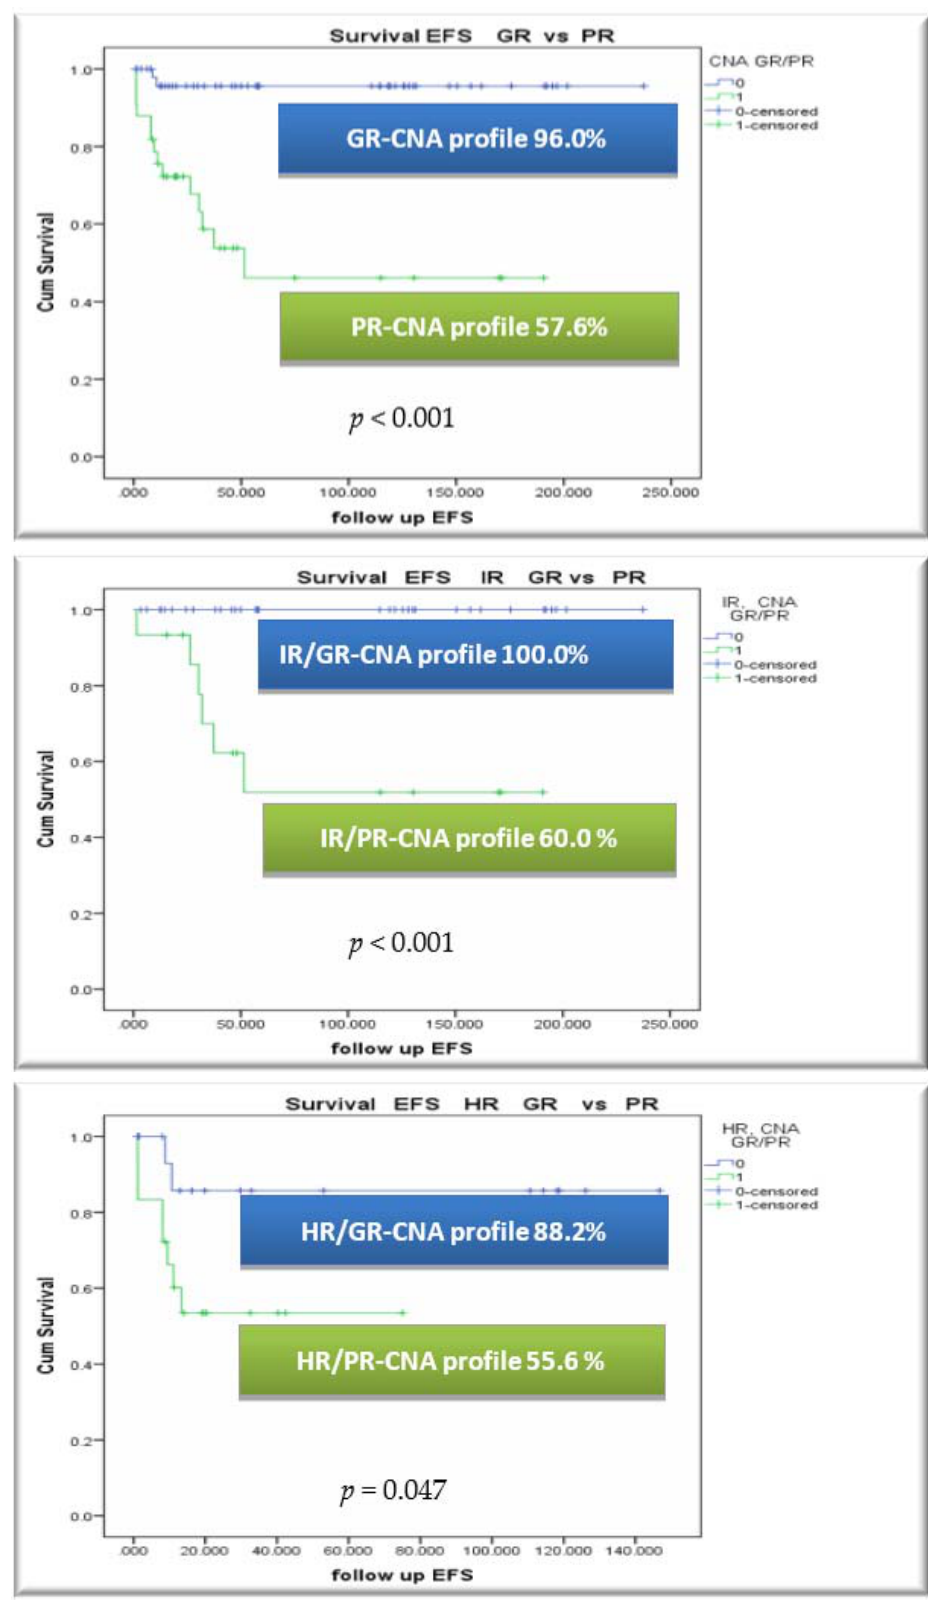
Figure 2. Survival rates by CNA risk index and EFS by CNA-profile within conventional protocol risk groups. ( A ) EFS by CNA profile in the whole patient cohort, ( B ) EFS by CNA profile within the intermediate risk (IR) group cohort, ( C ) EFS by CNA profile within the high risk (HR) group